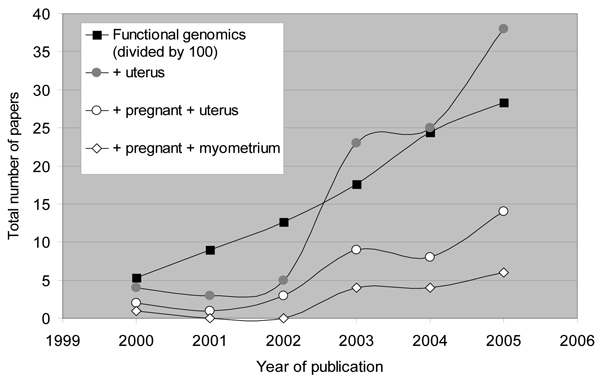
Number of articles referring to functional genomics in the PubMed database, years 2000 to 2005 [35]. Keywords for search strategy (limits: human): functional genomics OR microarray, (black squares); (functional genomics OR microarray) AND uterus (closed grey circles); (functional genomics OR microarray) AND uterus AND pregnant (open white circles); (functional genomics OR microarray) AND uterus AND myometrium (open white diamonds). On the graph, the number of papers is divided by 100 for the total papers on functional genomics OR microarray (black squares).